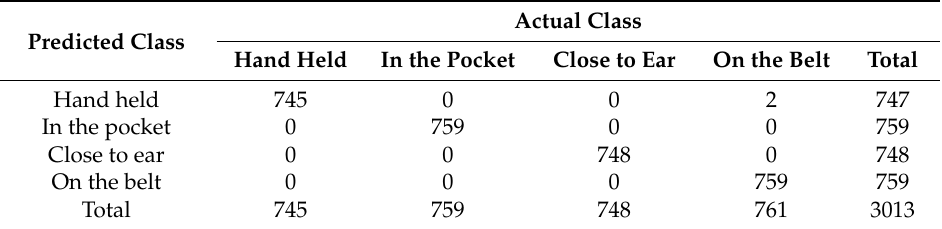
Figure 8. Accuracy of activity recognition. Table 2. Confusion matrix of different phone positions using decision tree (DT).